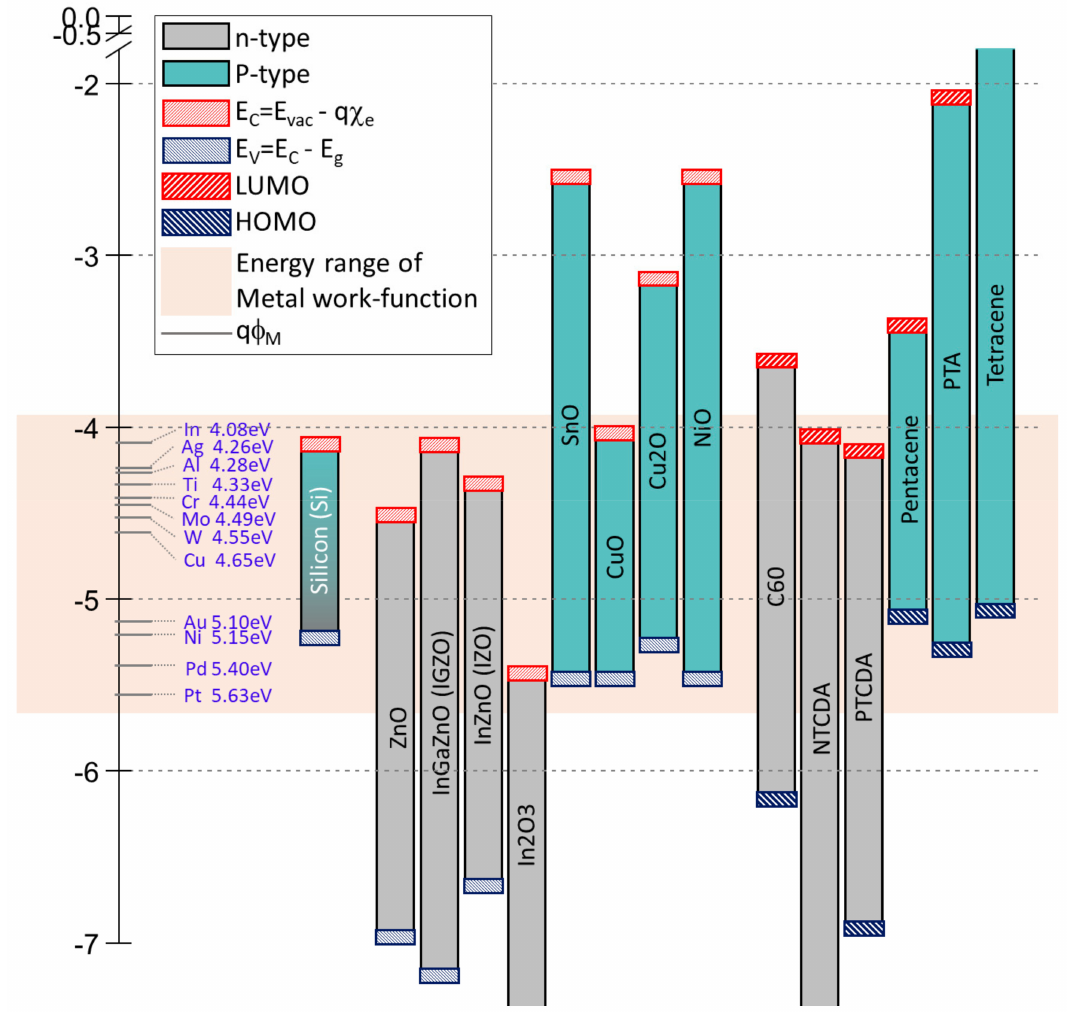
Figure 1. A graph compares energy band edge positions of n-type and p-type inorganic / organic semiconductor materials with a typical contact metal’s work-function